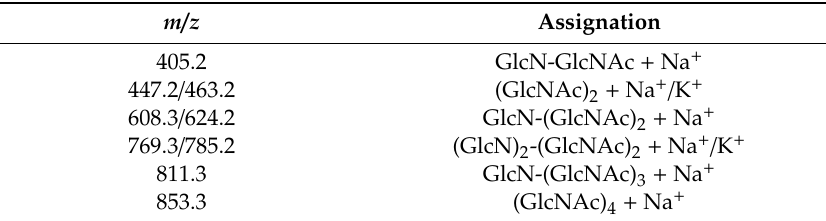
Table 2. Main identified signals in the MALDI-TOF mass spectrum of the reaction between chitinase Chit42 and colloidal chitin. Reaction conditions were as described in Figure 3.